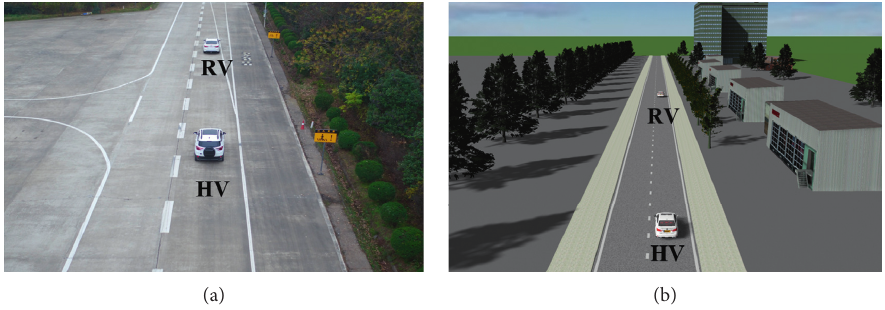
Figure 6: Valid communication testing scenario. (a) Actual test scenario. (b) Virtual test